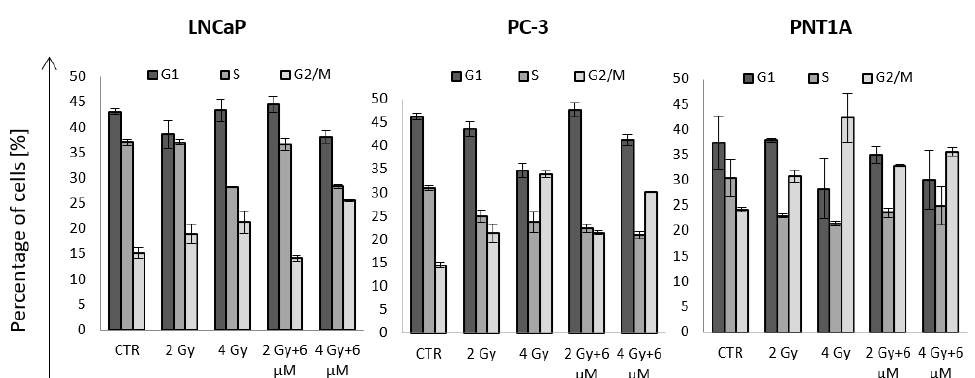
Figure 7. The percentage of cells in the G1, S, and G2 phases of the cell cycle after treatment with nanorods and radiation. The cells were irradiated with 2 and 4 Gy doses following incubation with nanorods at a concentration of 6 μM. LNCaP was irradiated after 6 h of incubation, PC-3 was irradiated after 4 h of incubation, and PNT1A was irradiated after 4 h of incubation. The values presented in the graph are the mean of the obtained results, and the deviation is the standard deviation. The experiment was performed in triplicate.